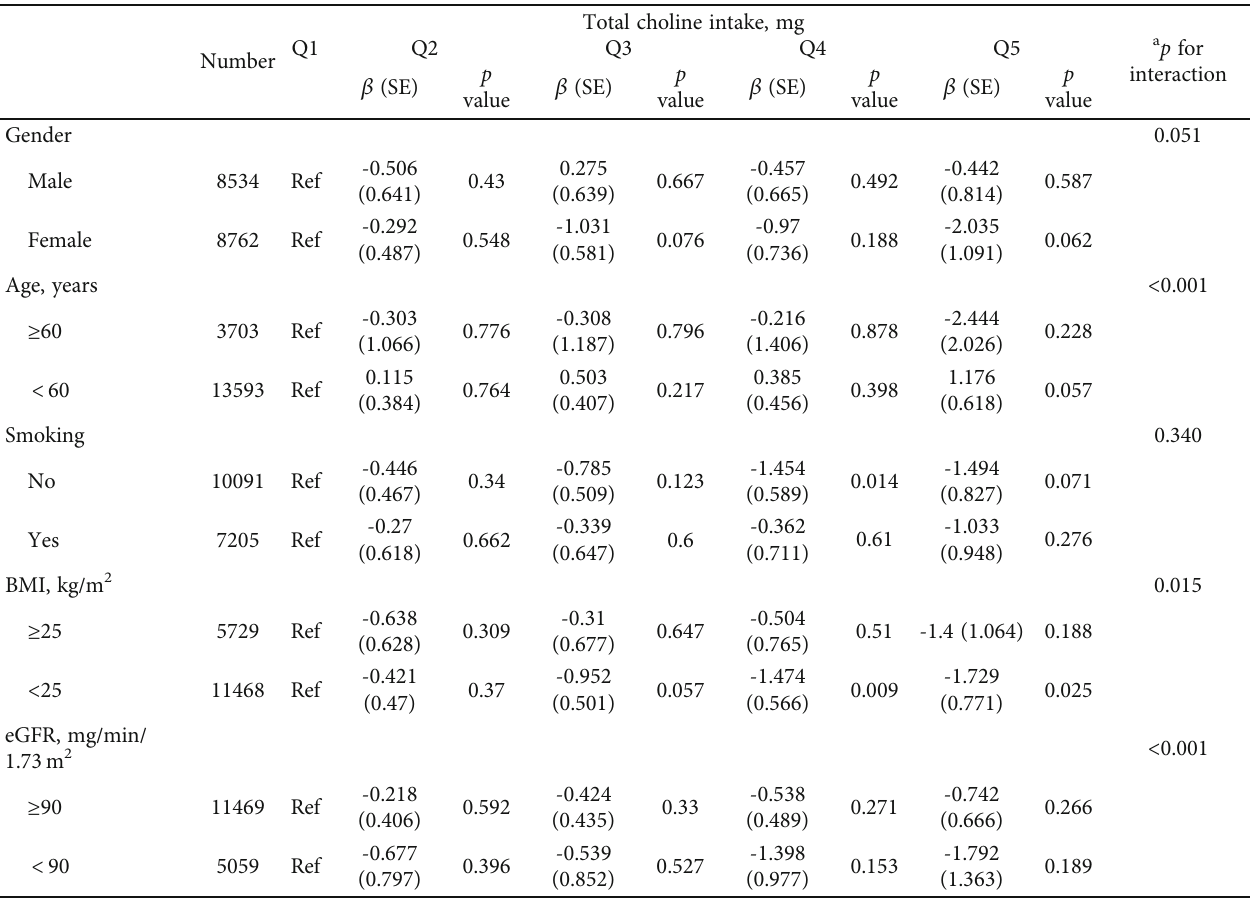
Table 5: Linear regression of total choline with systolic blood pressure after excluding patients using antihypertensive drug by subgroups.